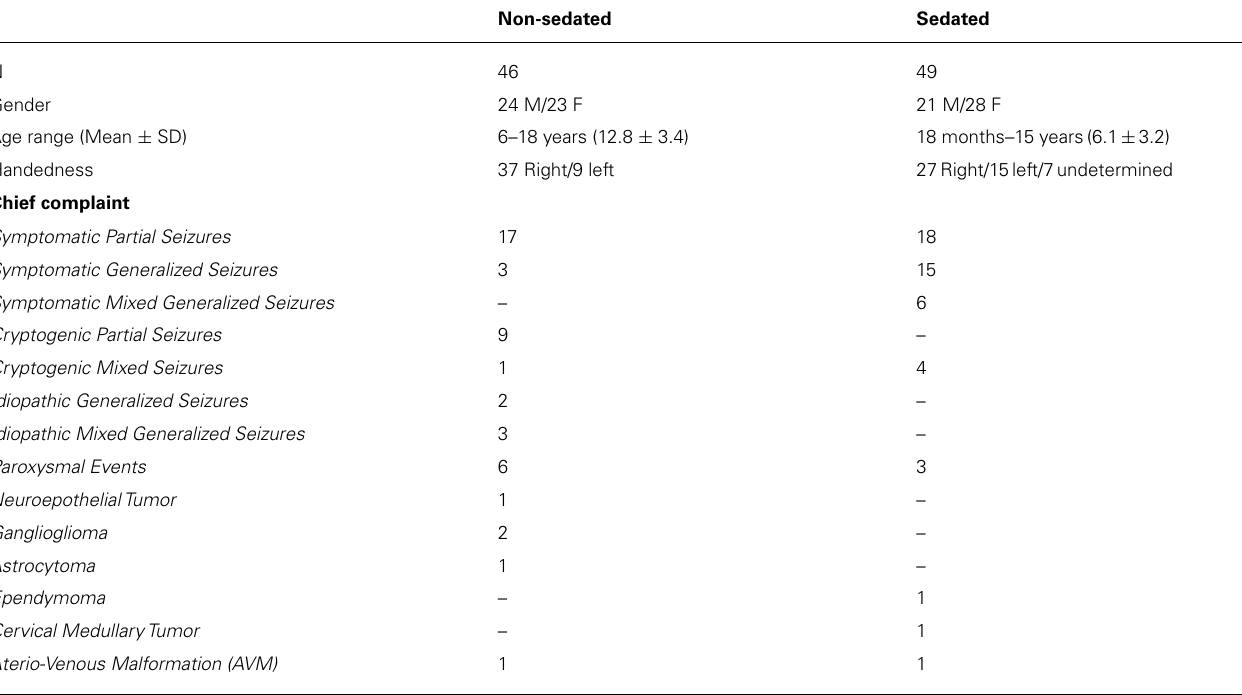
Table 1 | Clinical and demographic characteristics of patients having undergone receptive language mapping with and without